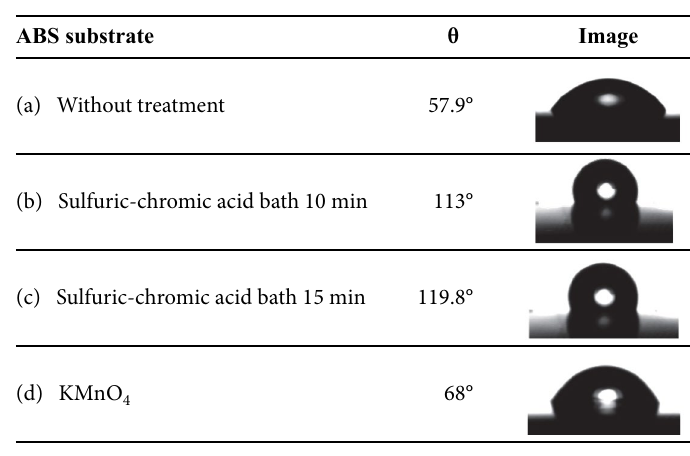
Table 1. The contact angles of ABS pieces for different surface